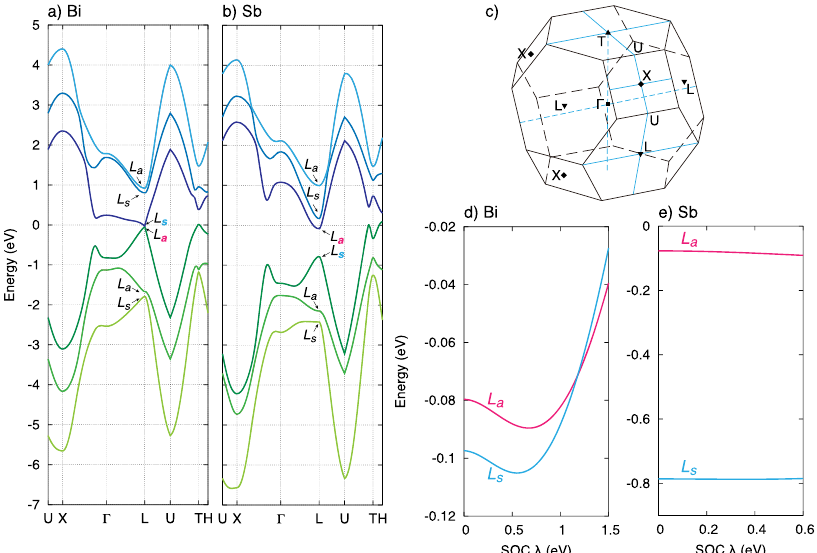
Fig. 7 Band inversion due to spin – orbit coupling. Band structure of a Bi and b Sb. In Bi, the gap between conduction and valence bands at the L -point is small and the hierarchy between them is inverted from the ordinary hierarchy under the Peierls transition. The upper band is the symmetric L s and the lower is the antisymmetric L a . c The Brillouin zone and its high-symmetry points. d , e Energies of L s and L a as a function of the magnitude of SOC for Bi and Sb. The effective λ for Bi and Sb yielding the best fi t to experiment are mentioned in Table 2. The energy hierarchy L s / L a is altered by SOC in Bi, whereas it is not in Sb. All these calculations were carried out by using the Liu-Allen ’ s tight-binding model 6